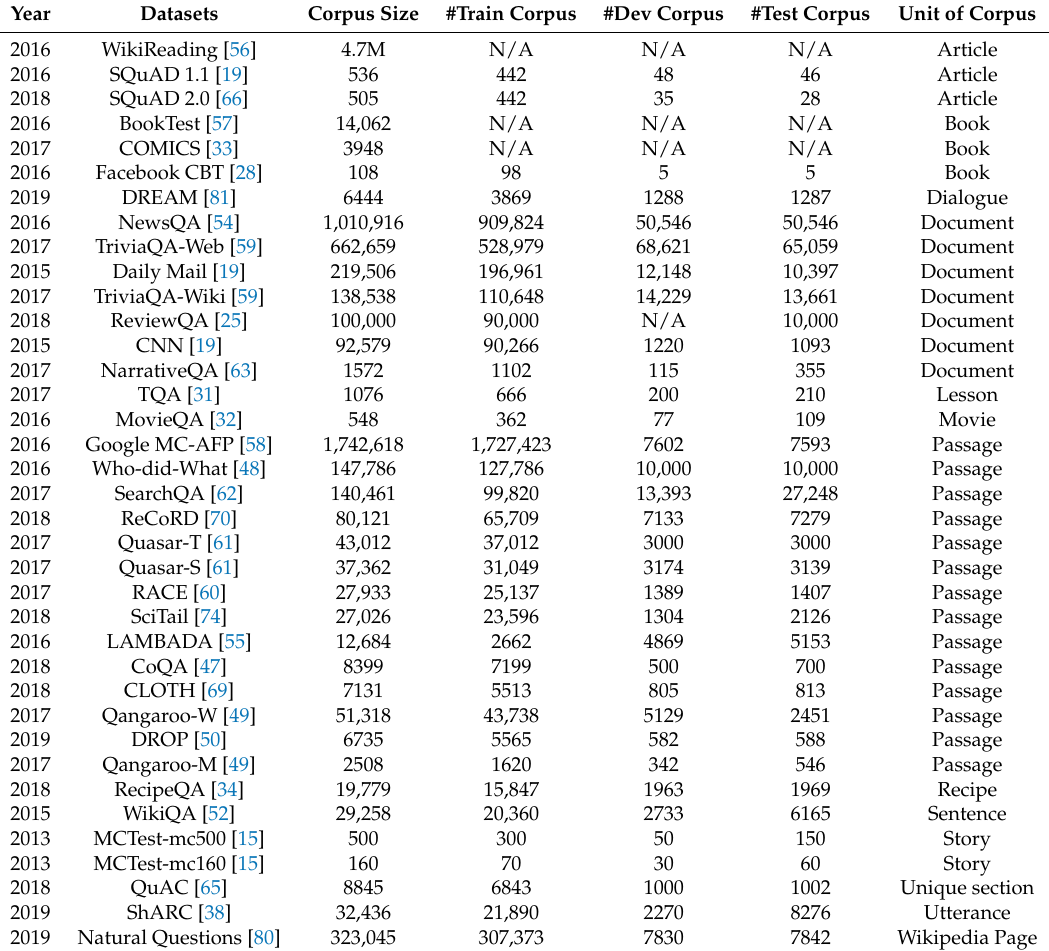
Table 5. The corpus size of machine reading comprehension